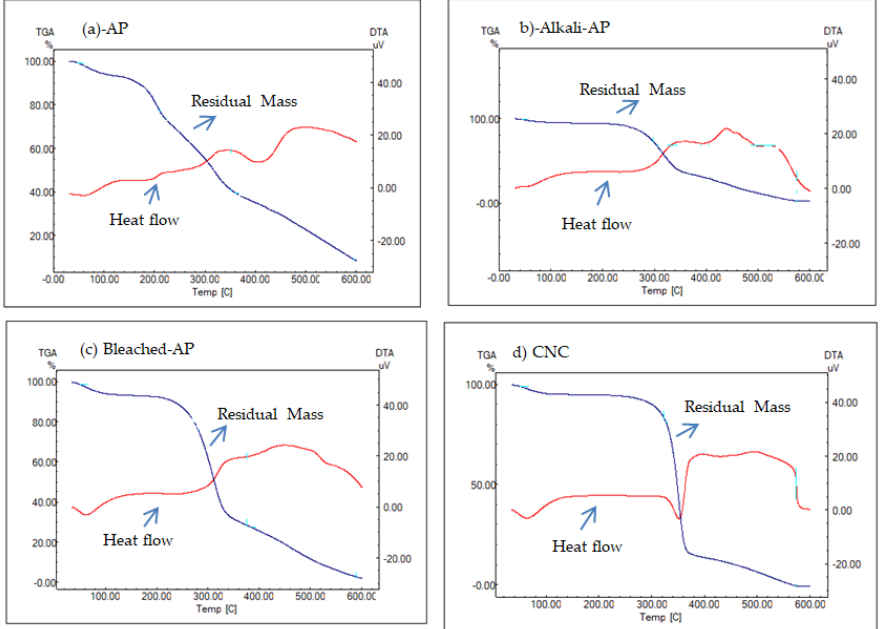
Figure 7. TGA curves for AP (apricot pomace), alkali AP, bleached AP, and CNC.